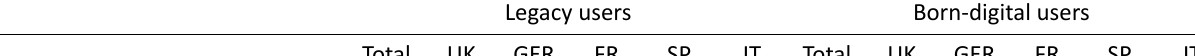
Table 6. Frequency distributions for media use, payment and media trust variables, 2019 (%). Legacy